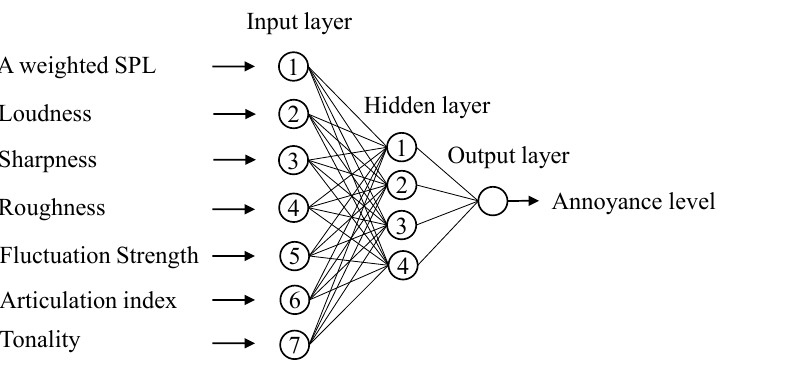
Figure 17. Shallow neural network sound quality model.